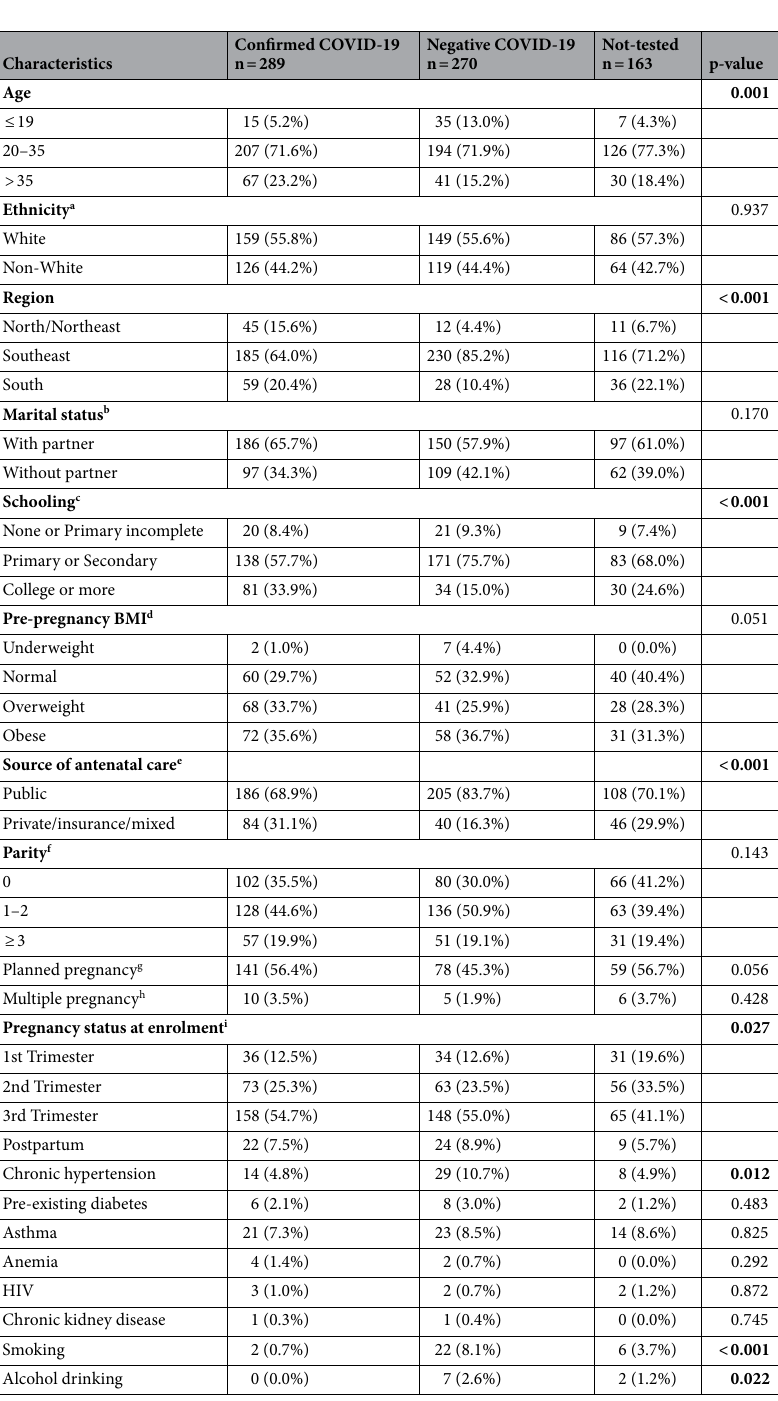
Table 1. Sociodemographic and obstetrical characteristics of women with suspected and confirmed SARS- CoV-2 infection in the 15 REBRACO participating maternities. Missing information for a 19, b 21, c 135, d 263, e 53, f 8, g 196, h 3, i 6. Significant values are in